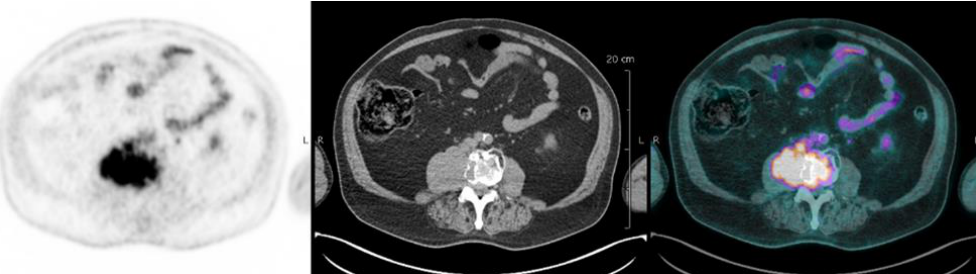
Figure 1. Focal hypermetabolism of an osteolytic lesion in the sternum.